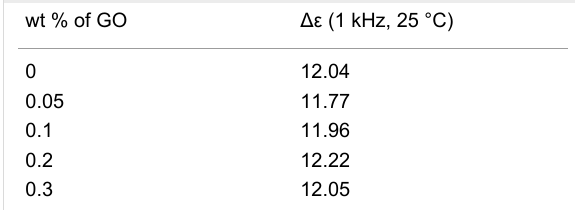
Table 1: Values of the electric anisotropy Δε in the 5CB-GO compos- ites as a function of the GO